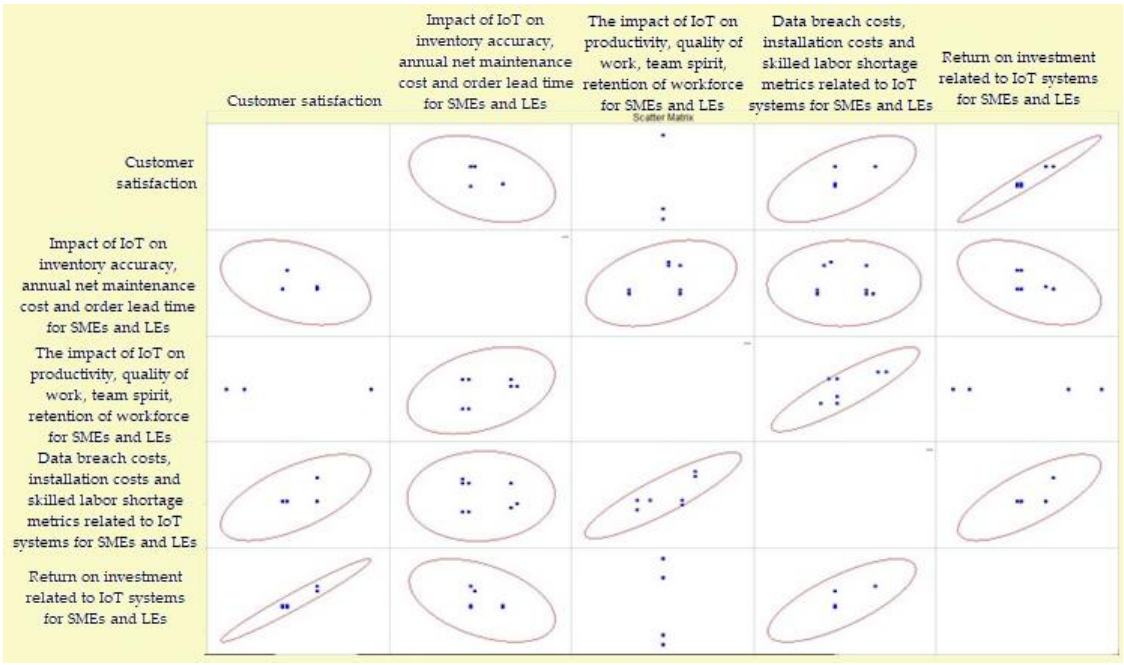
Figure 6. Interdependence of the studied